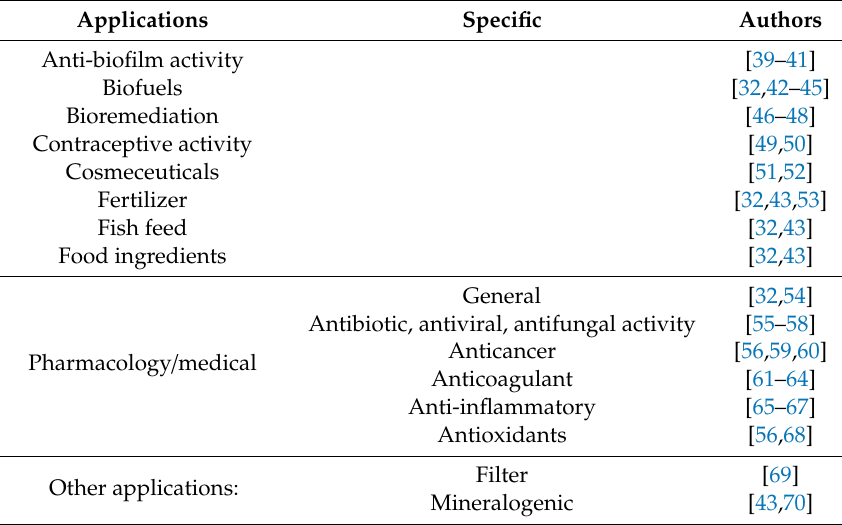
Table 3. Current marine algae